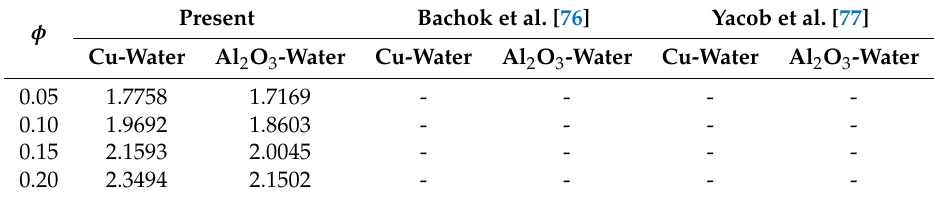
Table 8. Re − 1/2 x Nu x when λ = Z = d = 0, and Pr = 6.2 for various nanofluids.